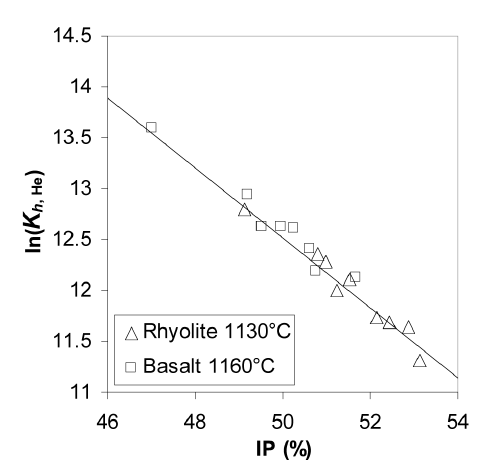
Fig. 9. Relationship between helium solubility ( K h in MPa and on 8-oxygen basis melt) versus Ionic Porosity (IP) in H 2 O and H 2 O-CO 2 bearing silicate melts (H 2 O and CO 2 contents up to 6 and 0.05 wt%, respectively). IP was calculated by taking into ac- count the effect of the main volatiles (see text). Line was calculated by using eq. (3.3) with m and n pa- rameters in Carroll and Stolper (1993) for dry melts, and it displays a very good agreement with the ex- perimental data (data from Paonita et al .,